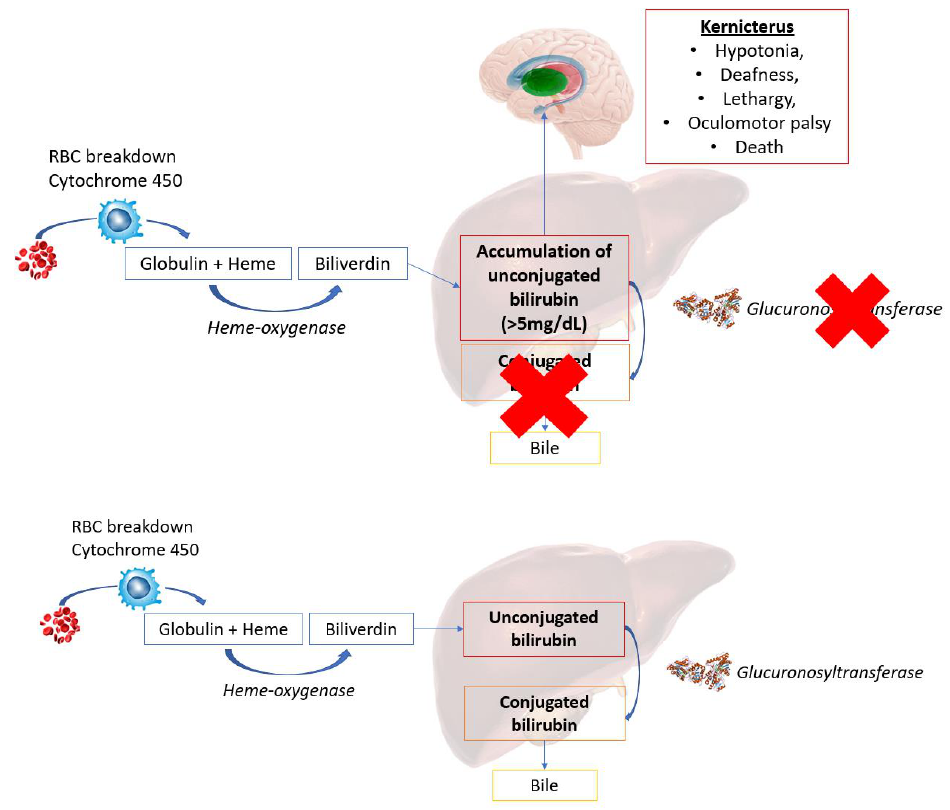
Figure 6. A schematic comparing functional and dysfunctional glucuronidation of unconjugated bilirubin in the liver. Dysfunctional glucuronidation is characteristic of Crigler-Najjar syndrome.